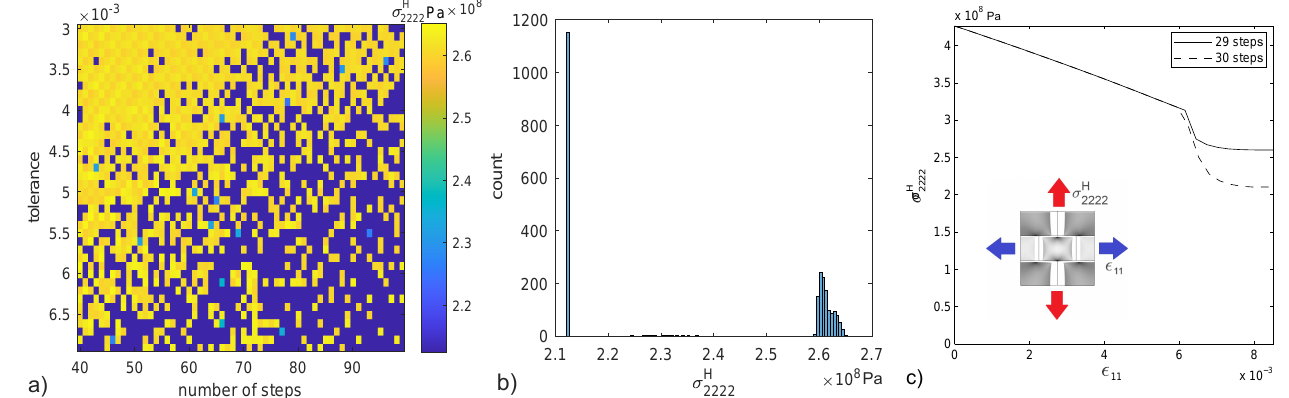
Figure 5. σ H value for the 2400 cases of the parametric test ( a ), histogram of the 2400 σ H 2222 ( b ) and stress-strain history for two cases representative of the two main groups of solutions seen in the histogram ( c ).